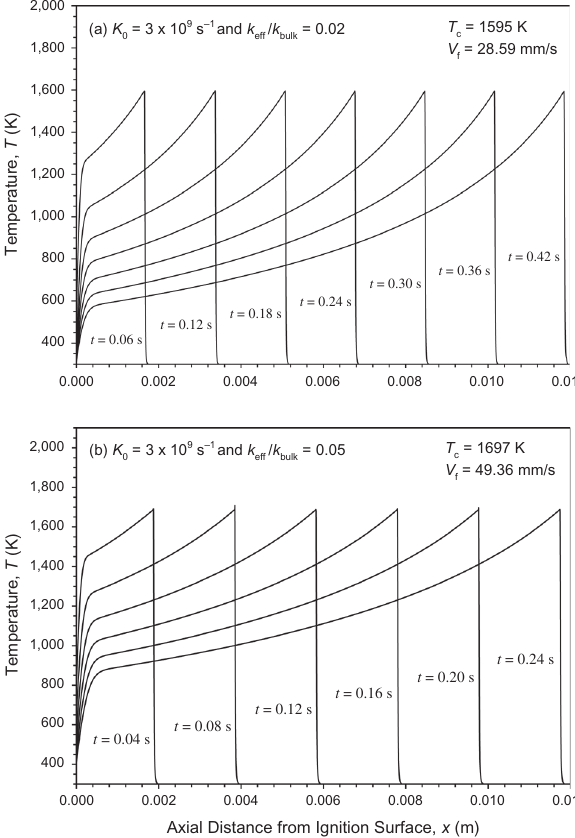
Figure 5: Calculated time histories of temperature profiles of Ti-Si powder compacts under (a) K 0 ¼ 3 (cid:2) 10 9 s − 1 and k eff / k bulk ¼ 0.02 and (b) K 0 ¼ 3 (cid:2) 10 9 s − 1 and k eff / k bulk ¼